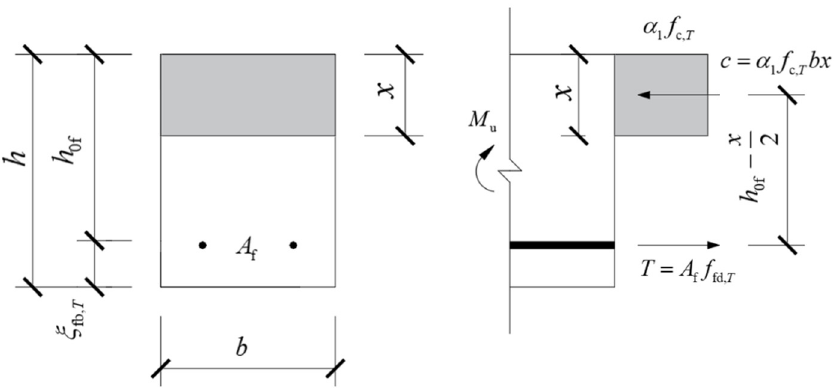
Figure 11. Equivalent stress diagram for cross-section bearing capacity of FRP-reinforced concrete beams after high-temperature exposure.